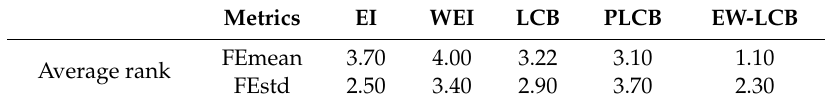
Table 4. Average ranking results for all AKBDO approaches considering all numerical cases.